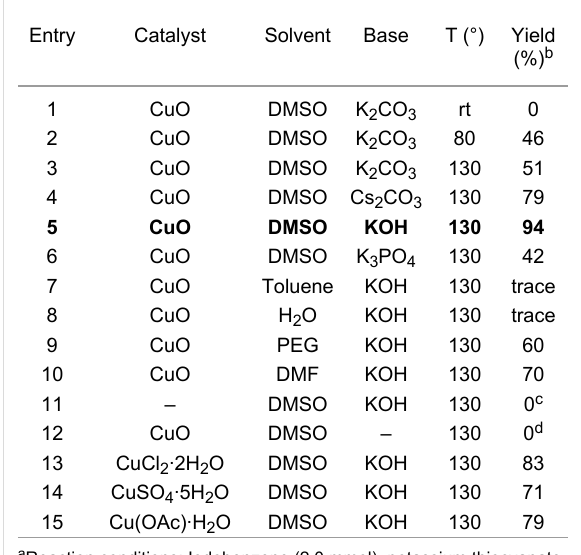
Table 1: Screening of copper sources for the cross-coupling reaction between iodo benzene and potassium thiocyanate.